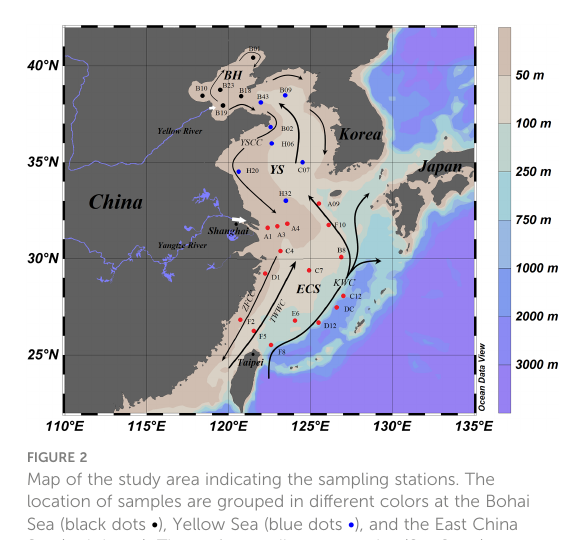
FIGURE 2 Map of the study area indicating the sampling stations. The location of samples are grouped in different colors at the Bohai Sea (black dots (cid:129) ), Yellow Sea (blue dots (cid:129) ), and the East China Sea (red dots (cid:129) ). The surface sediment samples (0 − 2 cm) were obtained during several research cruises during 2008-2013. The distributions of currents are based on Liu et al. (2007) and Qin et al. (1996). White arrows represent the Yellow River and Yangtze River discharge. (YSCC: Yellow Sea Coastal Current; ZFCC: Zhejiang Fujian Coastal Current; TWWC: Taiwan Warm Current; KWC: Kuroshio Warm Current). The map is created using Ocean Data View (ODV) software (Schlitzer, Reiner, Ocean Data View, https://odv.awi.de,